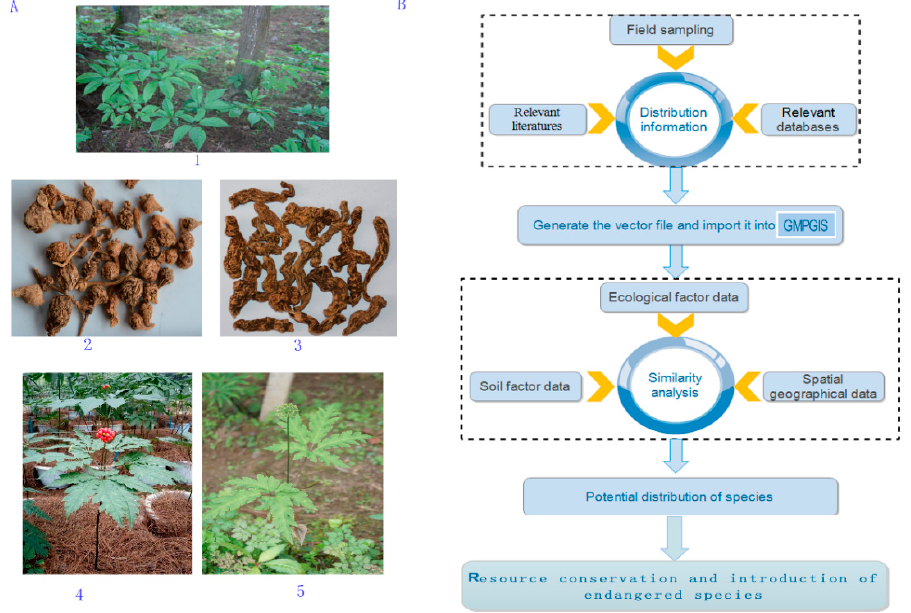
Figure 8. Picture of plant and materials ( A ) (1: P. japonicus , 2, 5: P. japonicus var. major , 3: P. zingiberensis , 4: P. stipuleanatus ), and flow-chart of potential distribution similarity analysis ( B ).